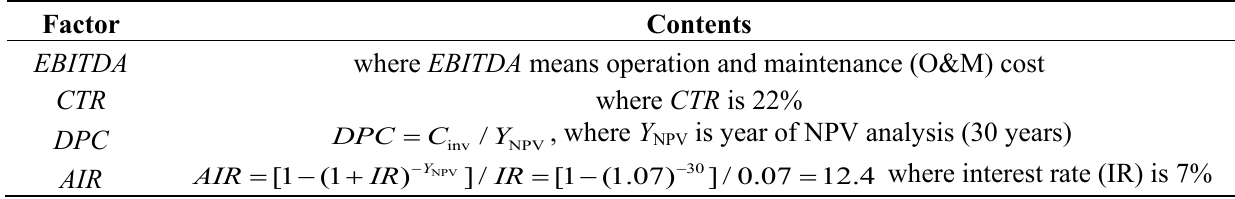
Table 12. NPV evaluation factors.